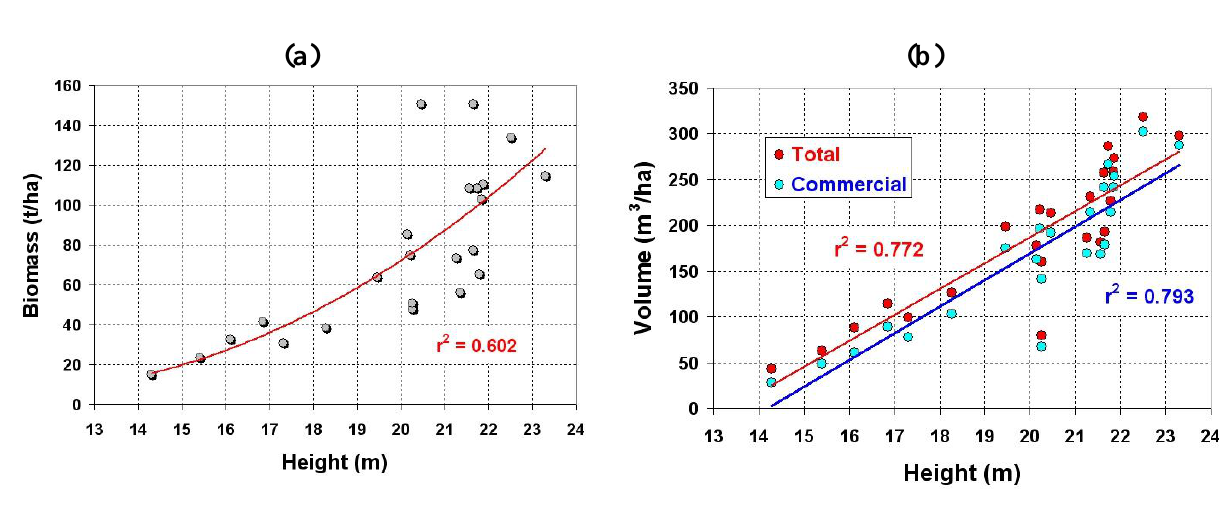
Figure 6. (a) Volume and tree heights; (b) Biomass and tree heights.